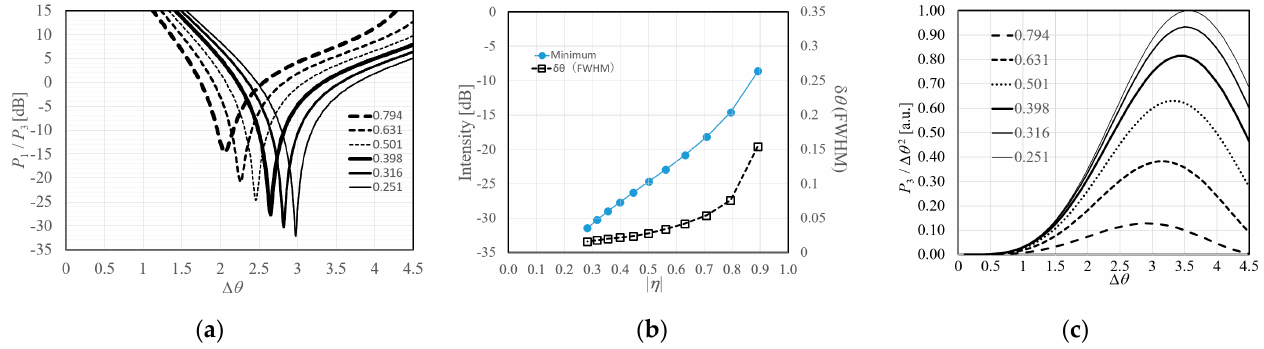
Figure 3. Alignment of the polarization axis of the polarizer and polarization state of an ( a ) incident lightwave and the output lightwave composed of ( b ) ±1st-order optical sidebands and ( c ) ±3rd-order optical sidebands. Note that the propagation axis (Z) of ( a ) is opposite to that of ( b , c ), while the spatial coordinate is consistent.